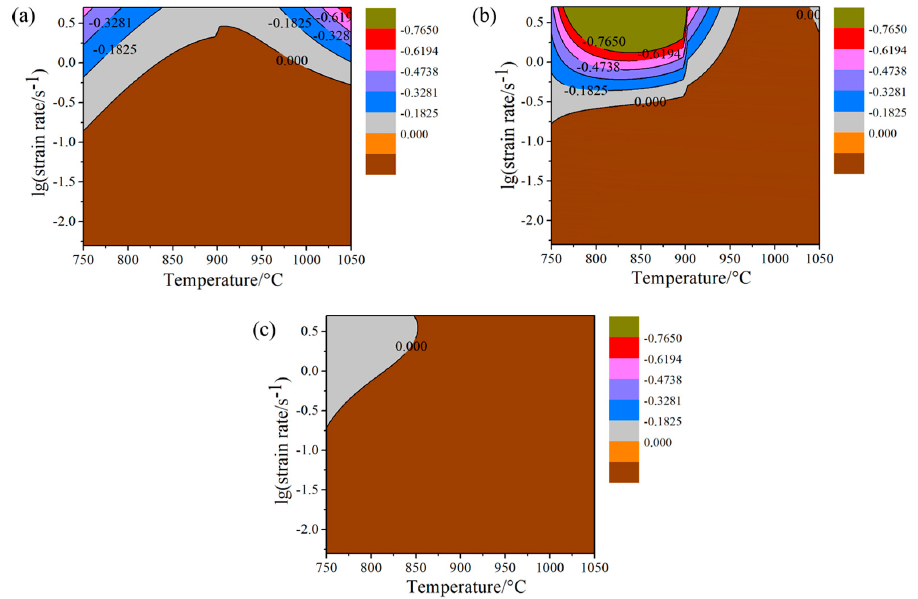
Figure 4. Instability maps of Ti555211 sample at the various strains: ( a ) 0.3; ( b ) 0.6; ( c ) 0.9. According to power dissipation maps and instability maps, processing map is con- structed to directly observe hot workability of Ti555211 sample, as shown in Figure 5. The processing maps cover a temperature range from 750 to 1050 °C, where the dual-phase region of α + β is on the left side of the red dotted line and the single-phase region of β is on the right side of the red dotted line because experimental measure shows that the phase transformation temperature of Ti555211 alloy is approximately 875 °C. The values on the η lines in Figure 5 represent the power dissipation efficiency during hot processing of Ti555211 alloy, where the purple shaded areas stand for the instability zones, whereas the other areas stand for the stability zones that are suitable for hot processing. It is generally accepted that the higher values of the power dissipation efficiency correspond to de- formation temperatures and strain rates, which contributes to hot processing of Ti555211 alloy [33]. It is noted in Figure 5 that peak values of power dissipation efficiency